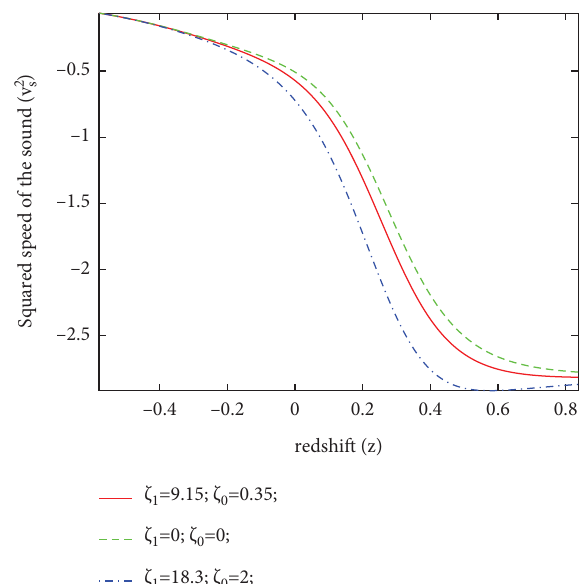
Figure 23: Squared speed of sound ( v 2